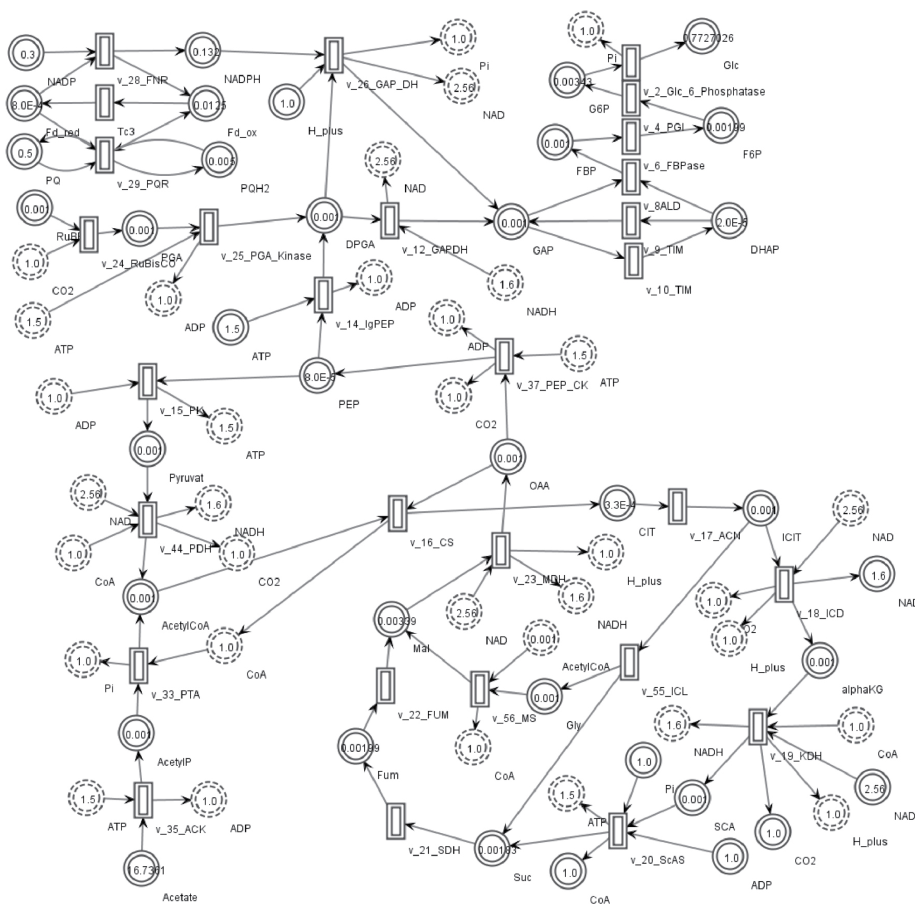
Figure 2: Petri net of the aerobic model. Places with dashed border represent logical